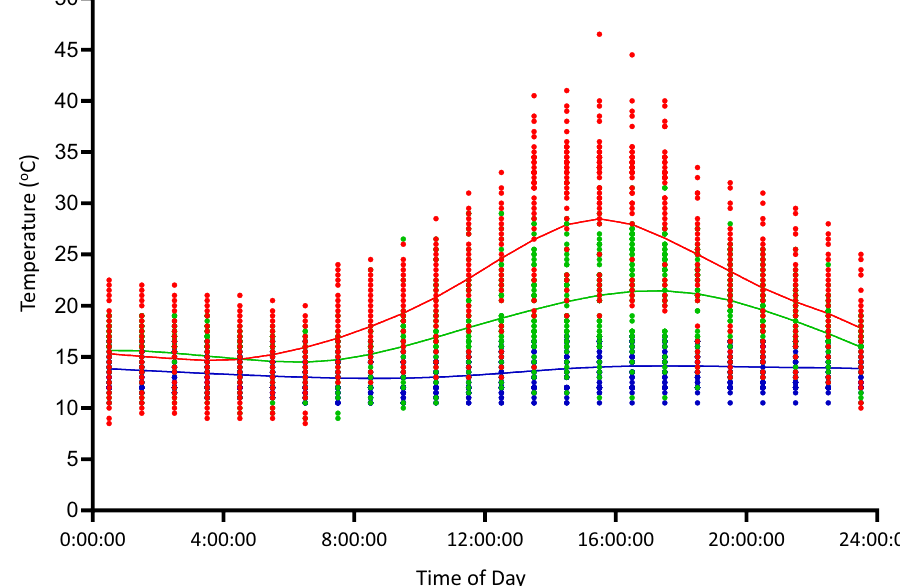
Figure 3. The diurnal variation of hourly soil temperature at the Picadilly circus field station. LOWESS curve fitted (solid lines) with a smooth curve to aid visual interpretation, (red): soil surface, green: at the depth of 10 cm and blue: at depth of 20 cm (blue). The minimum amplitude of the soil temperature variation approached in 20 cm depth. The daily variation of soil temperature showed a sinusoidal pattern, and the soil temperature decreased with the increase of the soil depth at all field stations. The order of the measured soil temperatures from high to low is: T0 cm > T10 cm > T20 cm.